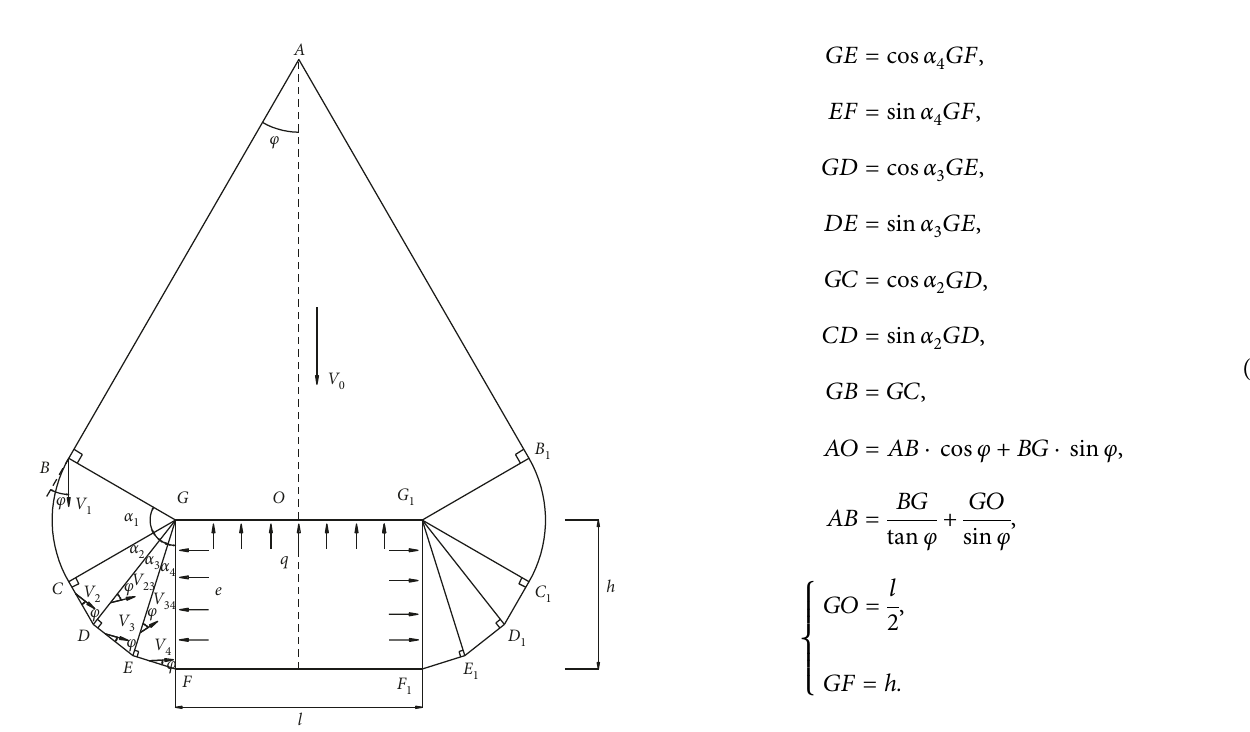
Figure 1: Diagrammatic sketch of circular sandwich failure